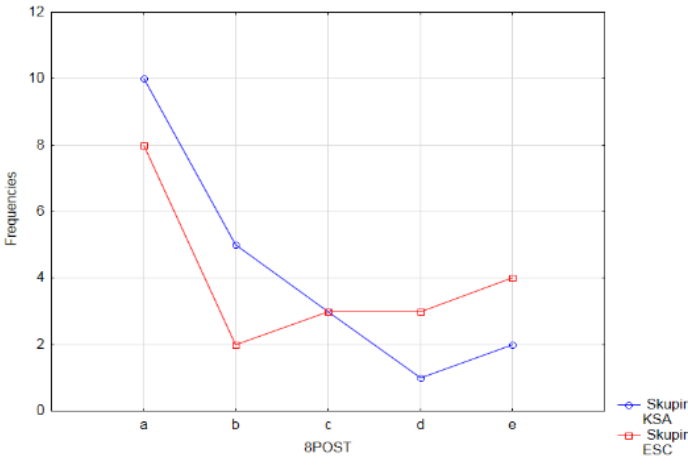
Figure 20. Interaction graph of the eighth item of the posttest - 8POST.